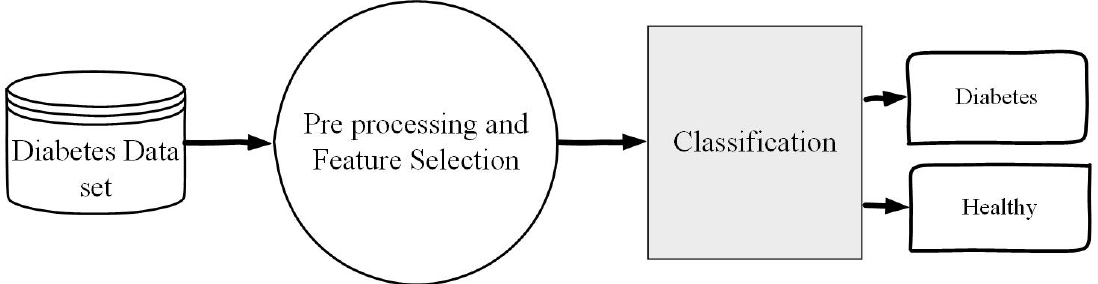
Figure 2. Flow chart of the proposed method of Diabetes